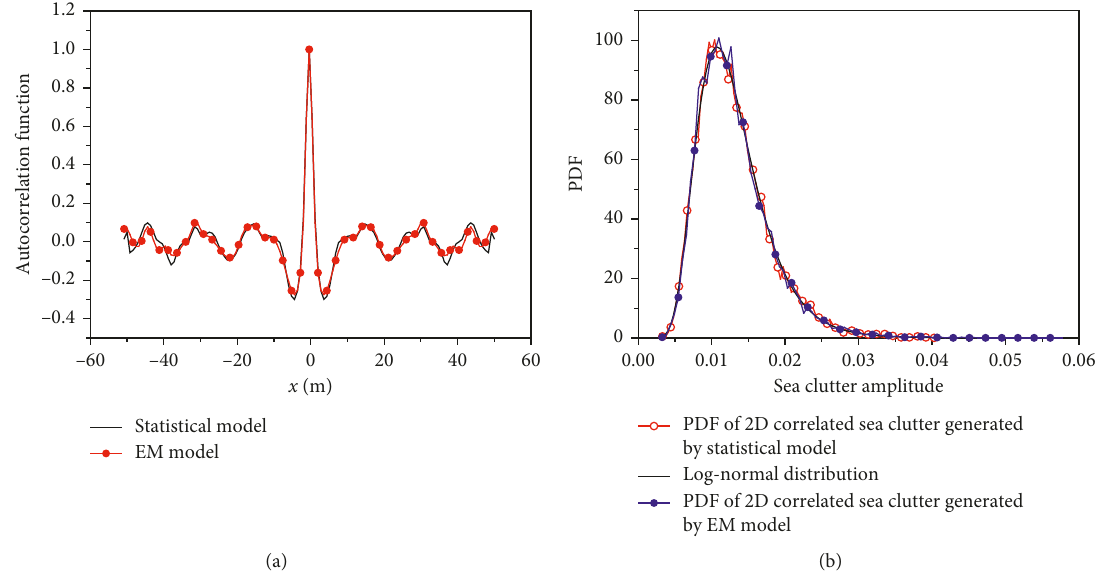
Figure 3: Comparisons of 1D plot of the autocorrelation function and PDF of 2D sea clutter generated by statistical and EM models. (a) 1D plot of the autocorrelation function. (b) PDF.